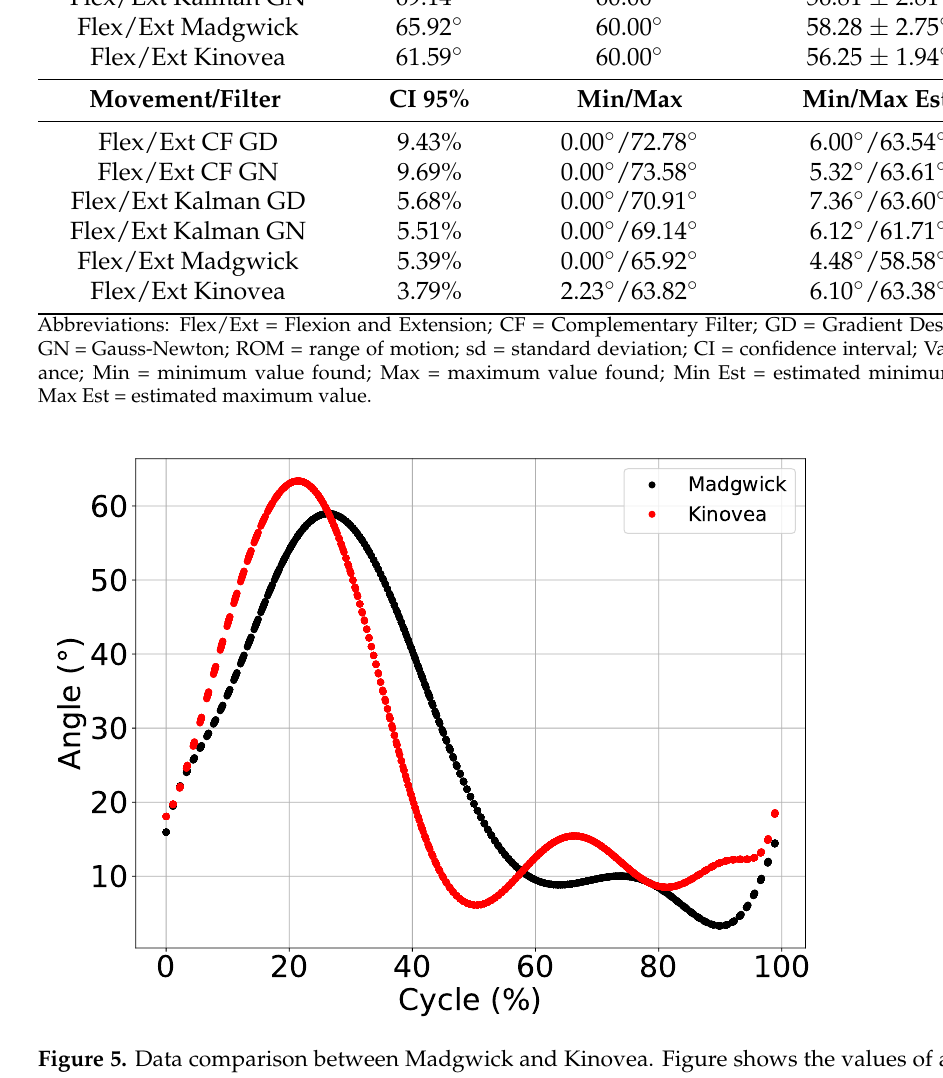
Figure 5. Data comparison between Madgwick and Kinovea. Figure shows the values of average ROM adjusted based on Min and Max, estimated based on the polynomial